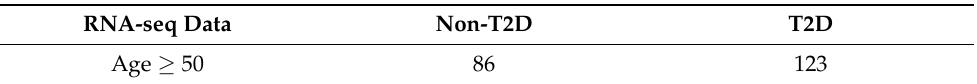
Table 1. Samples of RNA-seq data on pancreatic β -cells from GSE81608 were selected according to age greater than or equal to 50 years and classified into non-T2D and